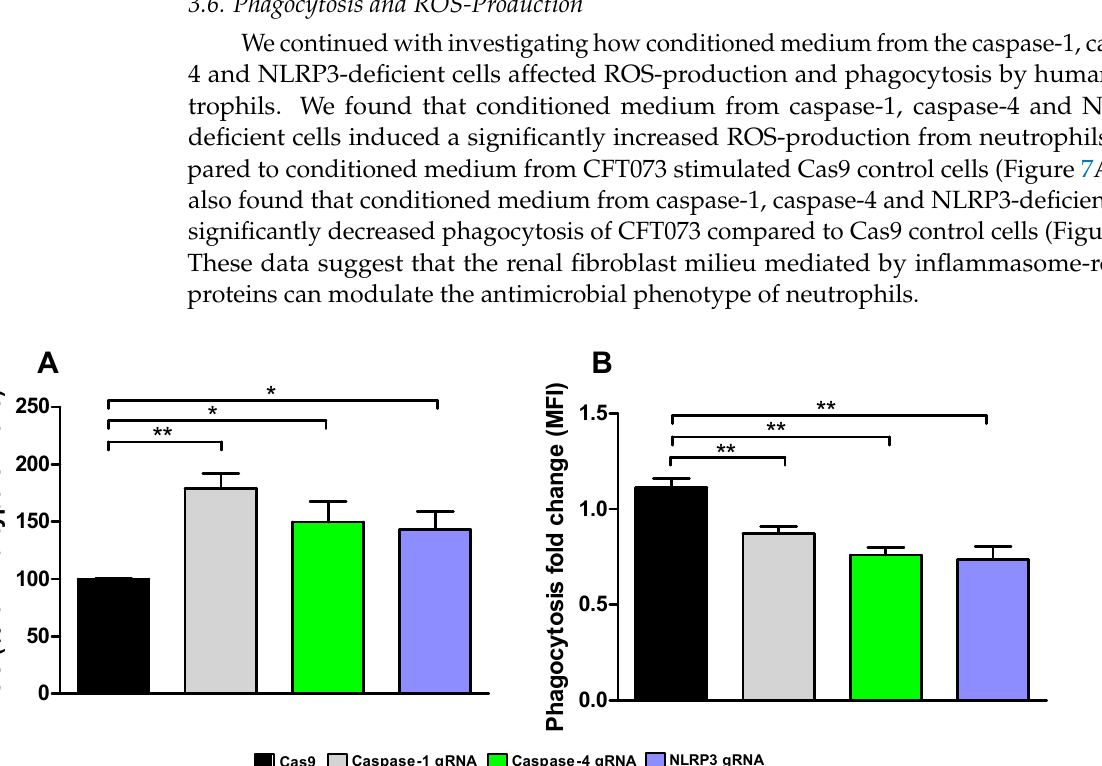
Figure 7. UPEC phagocytosis and production of reactive oxygen species (ROS). Neutrophils were subjected to conditioned medium from Cas9 controls, caspase-1, caspase-4 and NLRP3-deficient fibroblasts and ROS-production ( A ) was measured after 20 min and phagocytosis ( B ) of CFT073 (eGFP) was evaluated after 3 h. Phagocytosis is presented as fold change (mean florescence intensity) relative to the unstimulated control. ROS is presented as % of wild-type CFT073. Data are presented as mean ± SEM of 3 independent experiments (* p < 0.05, ** p < 0.01).